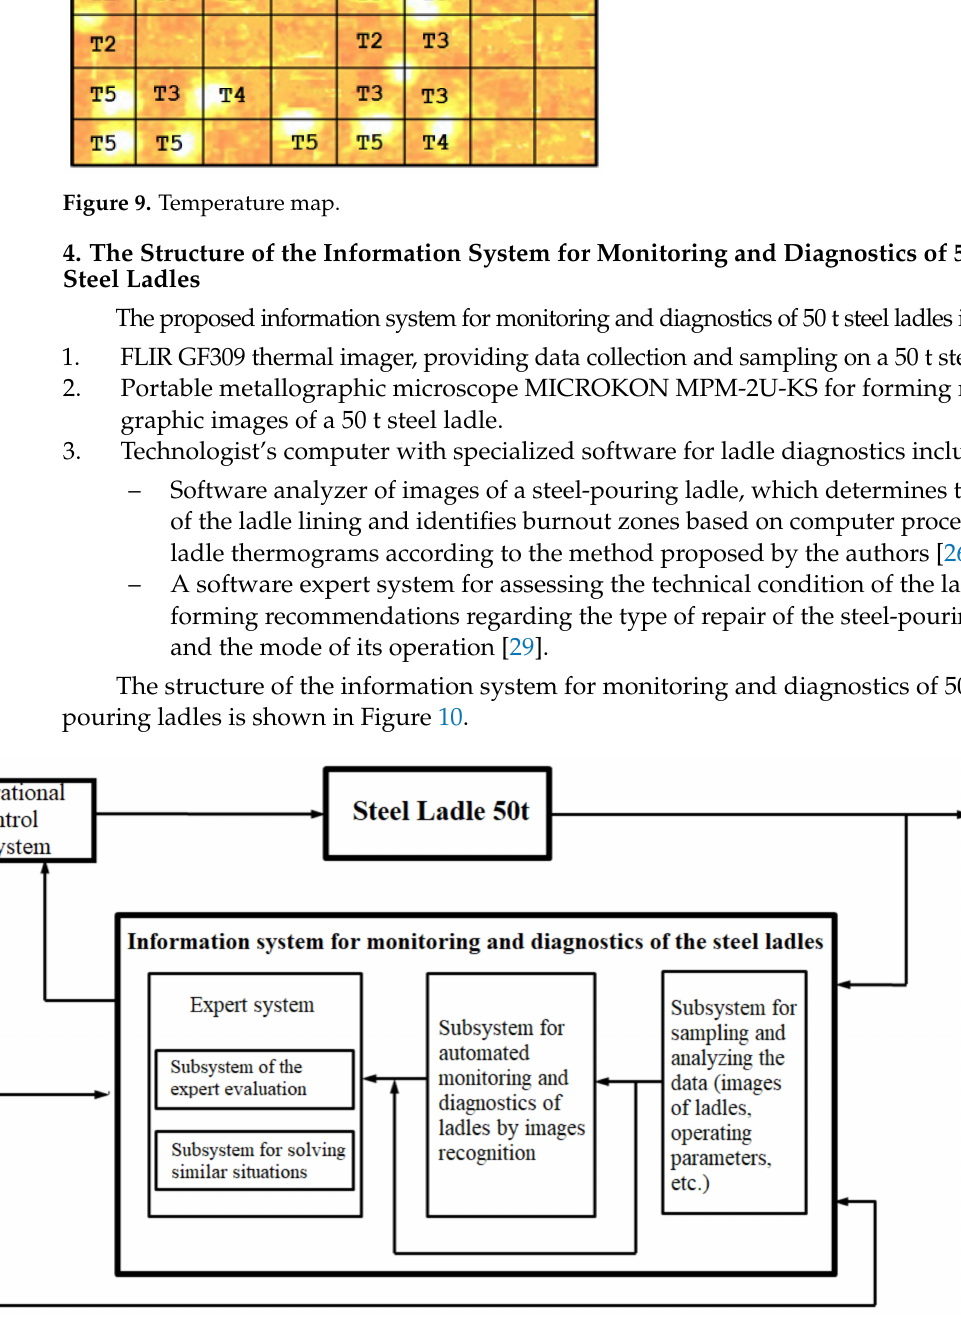
Figure 10. The functional structure of the information system for monitoring and diagnostics of 50 t steel